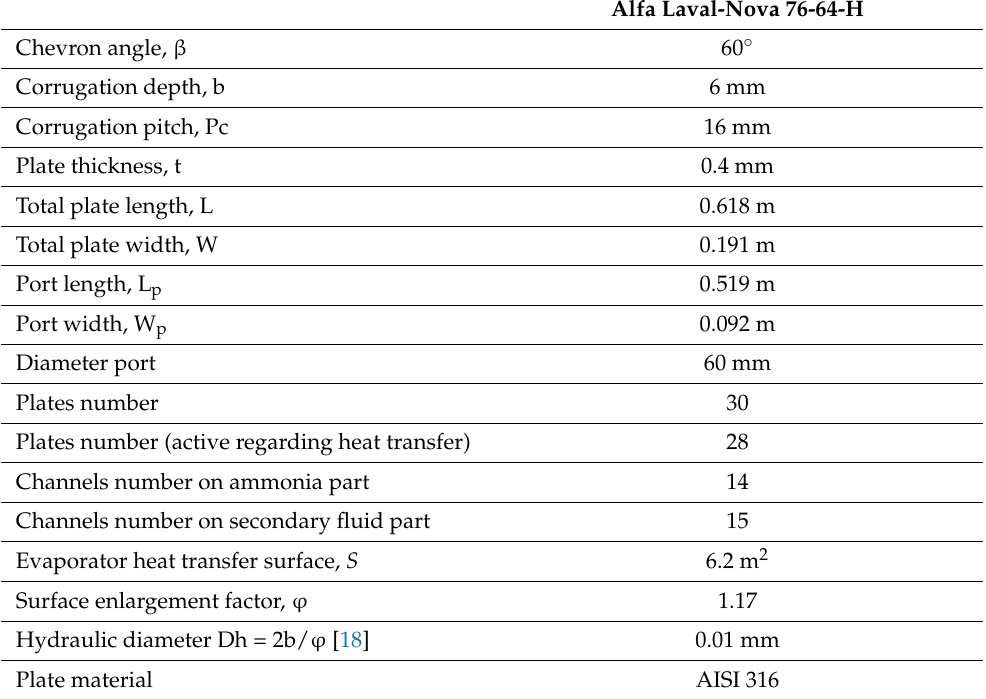
Figure 4. The plate evaporator plate technical scheme. Source: own elaboration. Table 2. Geometrical characteristics of the PHE.